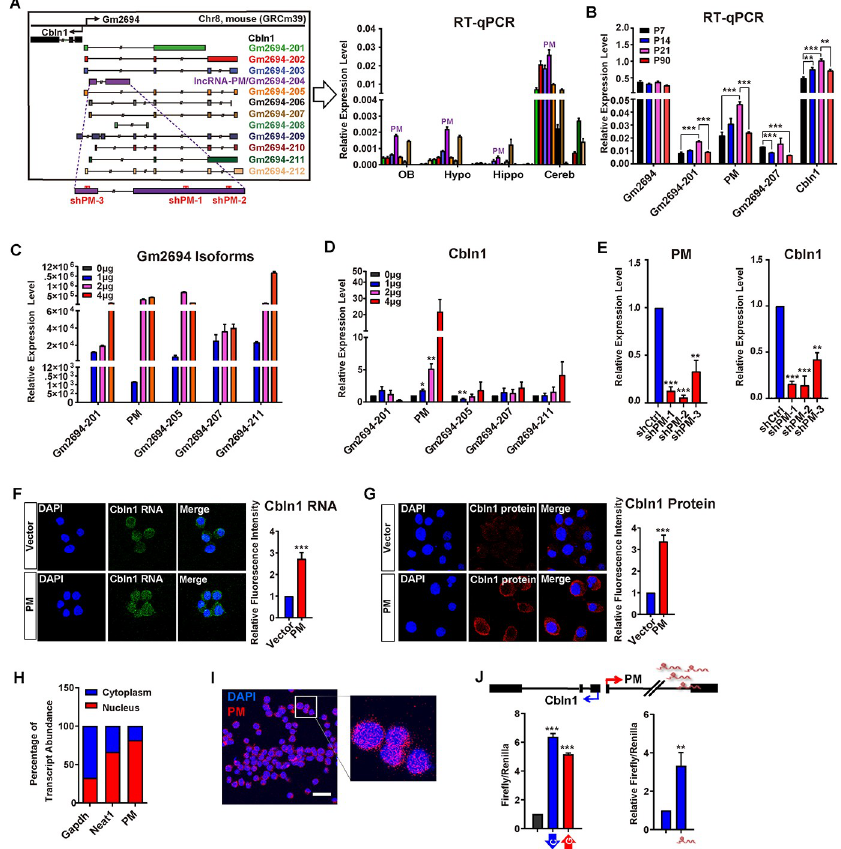
Fig 1. Identification of lncRNA-PM , a splicing isoform of Gm2694 , which is required for Cbln1 activation. (A) Left: illustration of 12 Gm2694 isoforms indicated as different colors. The sh PM -1, sh PM -2, and sh PM -3 used in the study were indicated. Right: the relative expression levels of the 12 isoforms of Gm2694 in the indicated brain regions. Data are shown as means ± SEMs, n = 3. Gm2694-204 is designated as lncRNA-PM (PM). (B) The relative expression levels of Gm2694 (for 201 , 202 , 203 , 205 , 206 , 207 , 209 , and 210 ), Gm2694-201 , PM , Gm2694-205 , Gm2694-207 , and Cbln1 at the indicated cerebellar developmental time points were measured by RT-qPCR. Data are shown as means ± SEMs, n = 3. (C, D) The expression levels of the indicated Gm2694 isoforms (C) and Cbln1 (D) under the indicated treatments. (E) The expression levels of Cbln1 in control or PM shRNAs (sh PM -1/2/3)-treated Neuro2a cells, detected by RT-qPCR. Data are shown as means ± SEMs, n = 3. (F) Left: representative images of Cbln1 mRNA in the control or PM -overexpressed Neuro2a cells, detected by FISH. Right: quantification of the left. Data are shown as means ± SEMs, n = 3. (G) Left: representative immunofluorescence images of Cbln1 protein in the control (Vector) or PM- overexpressed (PM) Neuro2a cells. Right: quantification of the left. Data are shown as means ± SEMs, n = 3. (H) Subcellular distributions of PM , Gapdh , and Neat1 by fractionating assay in Neuro2a cells. Gapdh and Neat1 RNA served as positive controls for RNAs predominantly expressed in cytoplasm and nucleus, respectively. Data are shown as means ± SEMs, n = 3. (I) Representative FISH image of PM RNA (red) in Neuro2a cells. Nuclei were stained with DAPI (blue). (J) Top: schematic illustration of the Cbln1 / PM locus. Bottom left: luciferase assays indicate the activity changes of pGL3- Cbln1 (blue) and pGL3 -Gm2694 (red), compared with pGL3 vector control (black). Bottom right: Luciferase assays indicate the activity changes of pGL3- Cbln1 in the presence of control or PM -expressing plasmid. Data are shown as means ± SEMs, n = 3. Scale bar, 13 um. All RT-qPCR results were normalized to Gapdh . All the data of this figure can be found in the S1 Data file. � P < 0.05, �� P < 0.01, and ��� P < 0.001. Cbln1 , Cerebellin-1 ; Cereb, Cerebellum; FISH, fluorescence in situ hybridization; Hippo, hippocampus; Hypo, hypothalamus; lncRNA-PM , lncRNA-Promoting Methylation ; OB, olfactory bulb; RT-qPCR, reverse transcription-quantitative